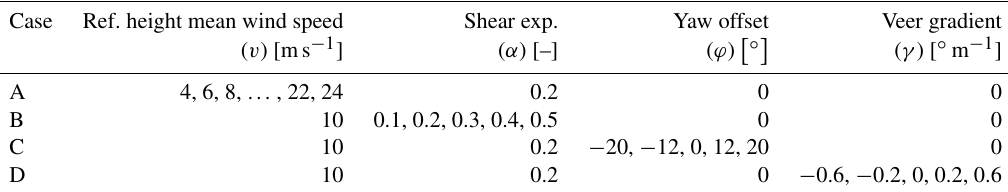
Table 2. Simulated steady mean wind cases. The mean wind speed reference height is 90m, with power-law shear profiles also referenced to this height.